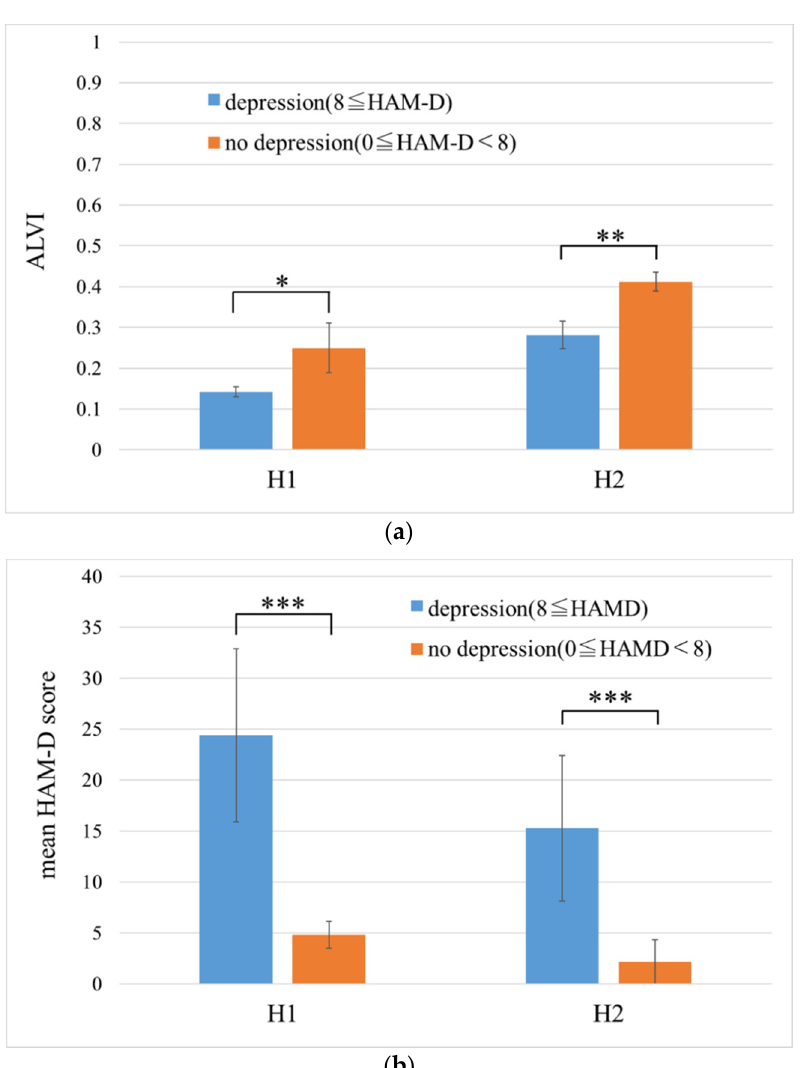
Figure 4. ( a ) The mean arousal level voice index for depression and no depression groups per hospital. Error bars represent standard error. ( b ) The mean HAM-D score for depression and no depression groups per hospital. Error bars represent standard deviation. *** ( p < 0.001), ** ( p < 0.01), * ( p < 0.1). (Note. HAM-D: Hamilton Rating Scale for Depression; H1: Ginza Taimei Clinic; H2: National Defense